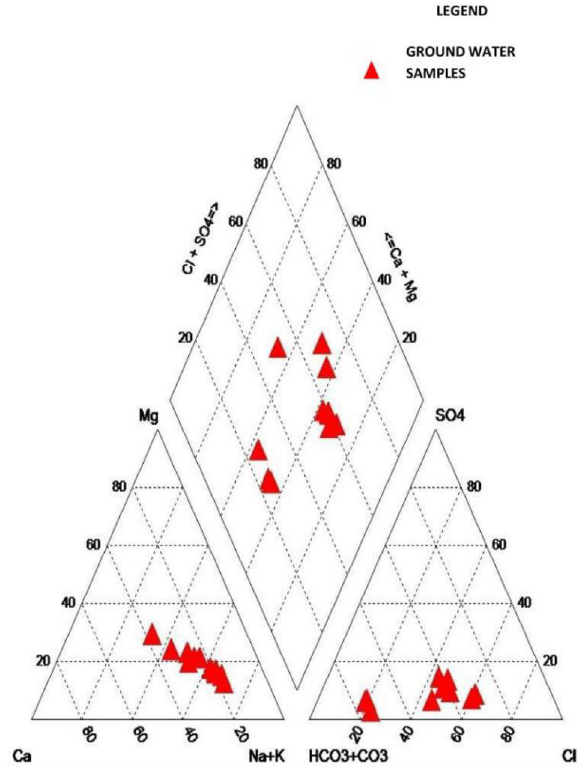
Fig. 2 Piper trilinear diagram of 18 groundwater samples of